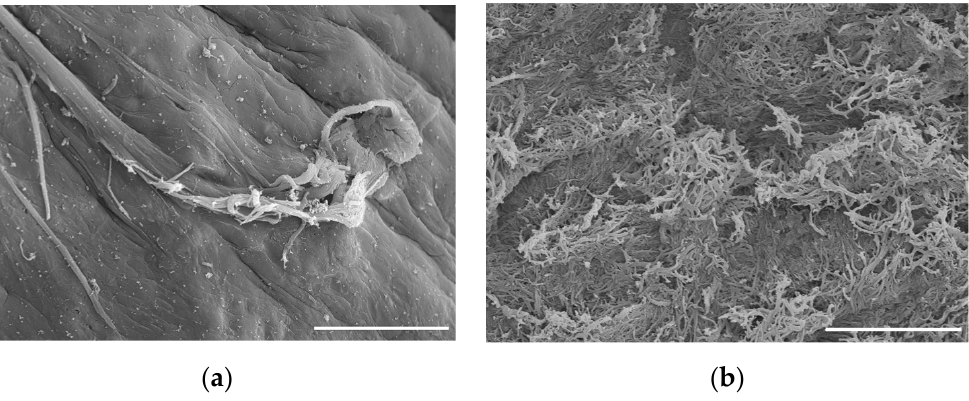
Figure 4. Visualization of cartilage by scanning electron microscopy. ( a ) Cartilage prior to decellu- larization. Tissue appears visibly smooth and intact. ( b ) Final decellularized cartilage surface. Tissue displays increased surface area and exposed collagen network. Scale bar = 20 µm. Adapted with permission from Ref. [49] 2021, Stone and Oxford.